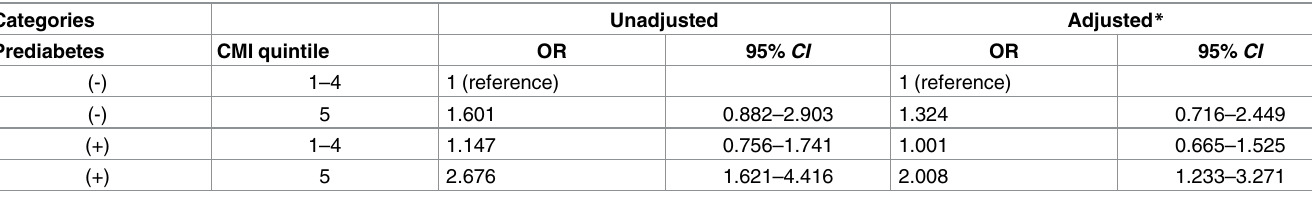
Table 4. Interactive effect analysis of CMI quintile and prediabetes on